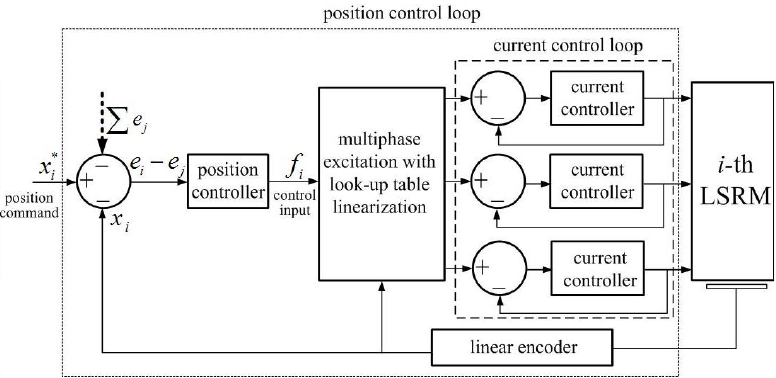
Figure 4. Unit system control